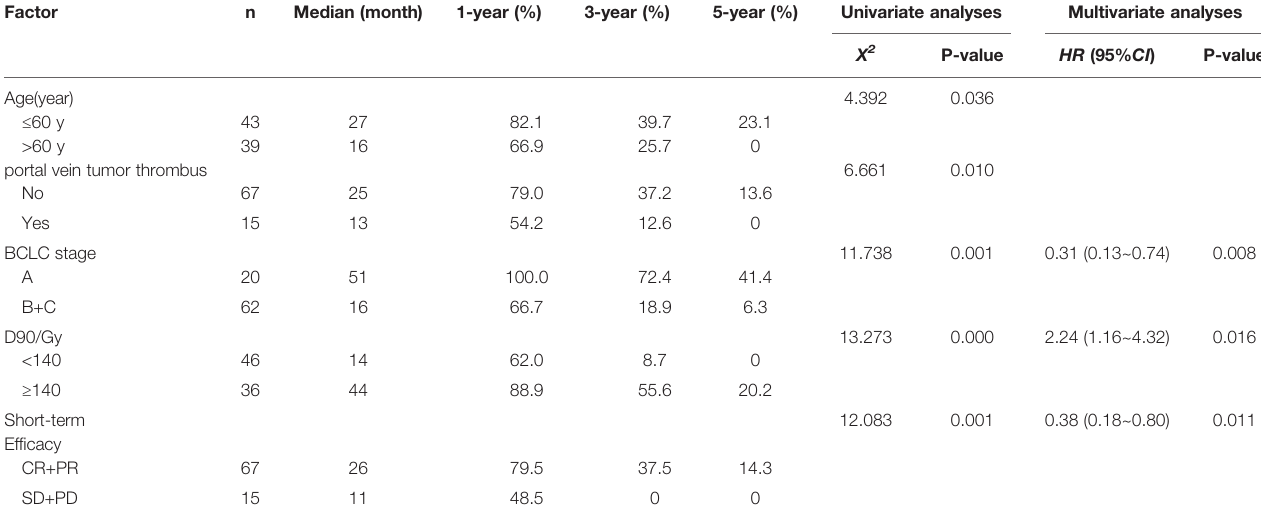
TABLE 4 | Univariate and multivariate analyses of factors in fl uencing overall survival. Factor